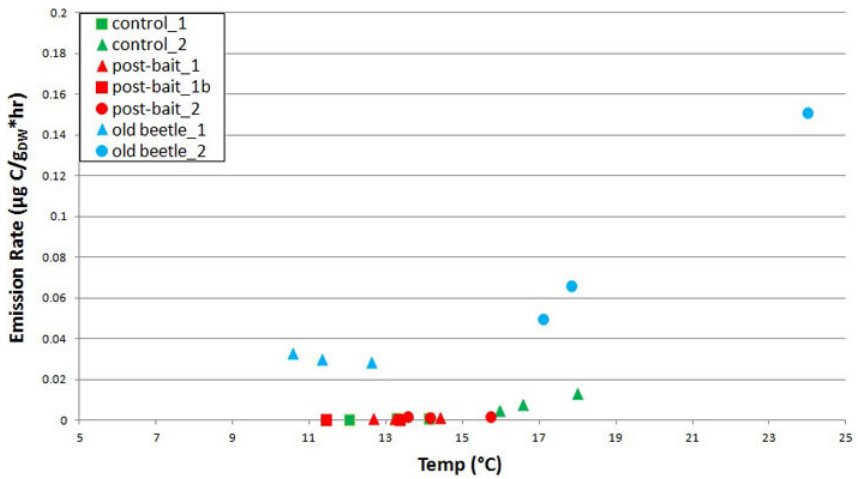
Fig. 4. SQT emissions observed during the last MRS sampling visit (17–18 September), plotted as a function of